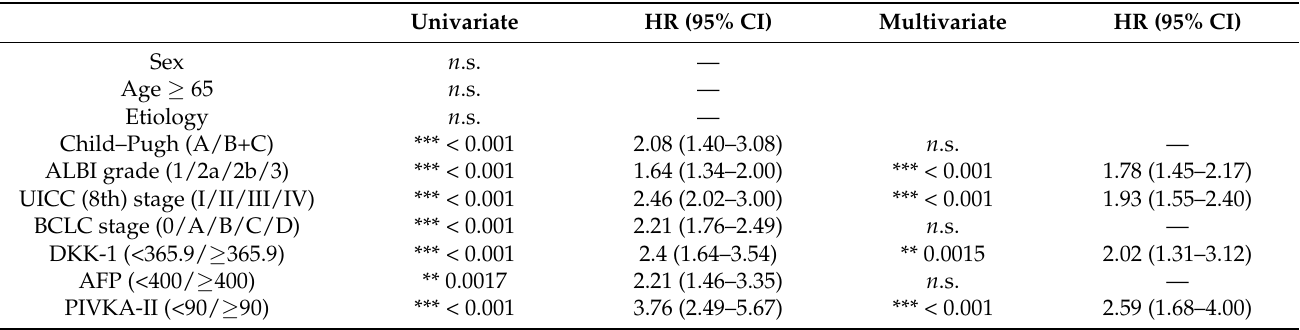
Table 4. Multivariate analysis of clinical characteristics for overall survival using the Cox proportional hazards model.